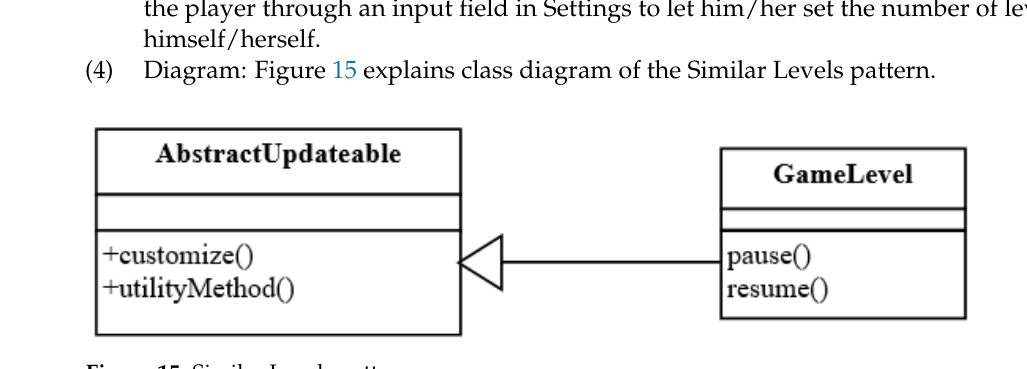
Diagram: Figure 15 explains class diagram of the Similar Levels pattern.